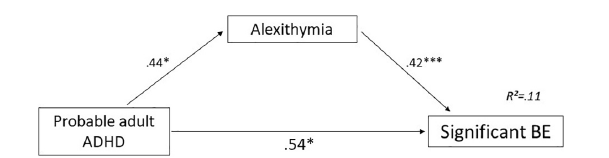
FIGURE 2 | Mediation effect of alexithymia in the association between probable adult ADHD and significant BE. Unstandardized regression coefficient. ∗ p < 0.05; ∗∗∗ p < 0.001. ADHD: attention-deficit/hyperactivity disorder; BE, binge eating. Black arrow: Significant